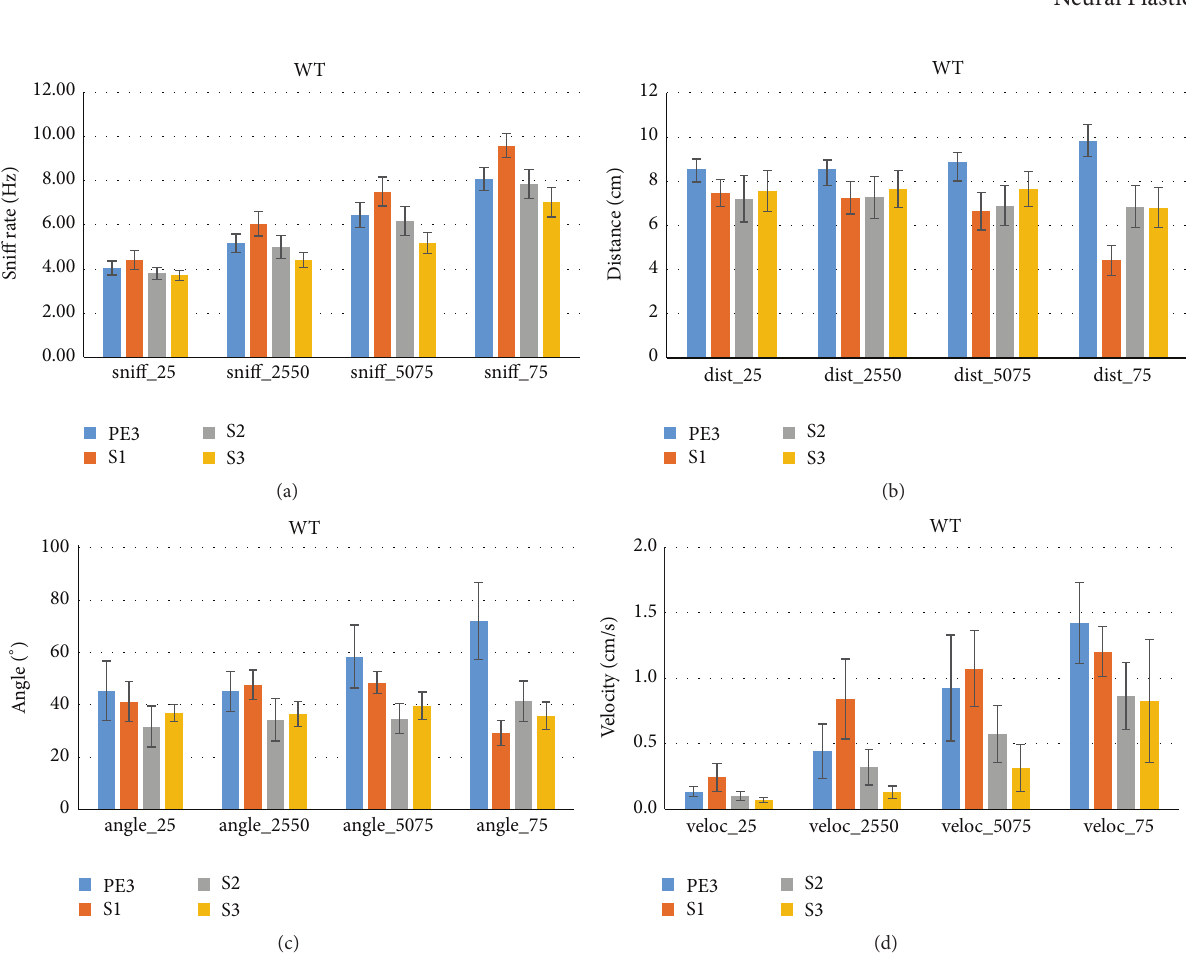
Figure 6: Sniff rate quartiles discriminate S1 proximity and consistently reveal WT mouse velocity. We explored how behavior varied as a function of sniff rate. For each trial type (PE3, S3) the 100ms time bins were assigned to one of four quartiles of WT ( 𝑛 = 7 ) sniff rates (0th– 25th, 25th–50th, 50th–75th, and 75th–100th percentile, (a)). Their associated nose distance (b) and head angle (c) to the odor source, as well as their velocity (d), were determined. Distance and to some extent head angle to the object were lower for the S1 trial during the high sniff rate top quartile time bins. Velocity consistently increased with increasing sniff rates across all trial types. FUS mice showed similar patterns (not